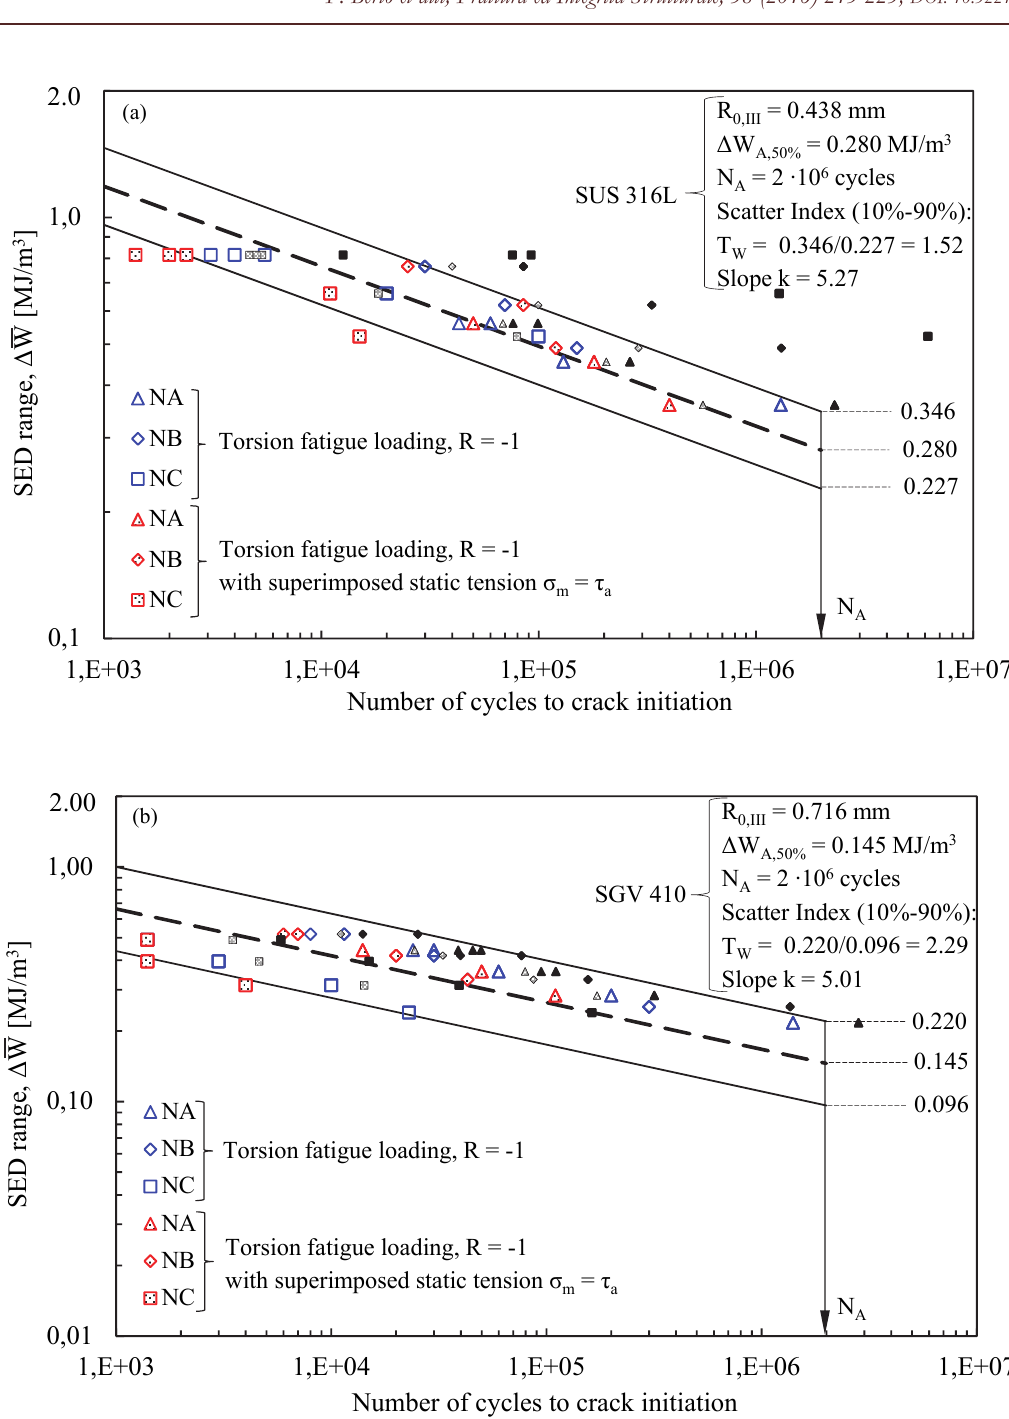
Figure 5: Averaged SED-based scatter-band calibrated on the crack initiation experimental fatigue results for (a) SUS 316L and (b) SGV 410 steels. The smaller symbols indicate the total fatigue life for comparison purposes: the black ones are for pure torsion loading, while the gray ones are for torsion loading with superimposed static